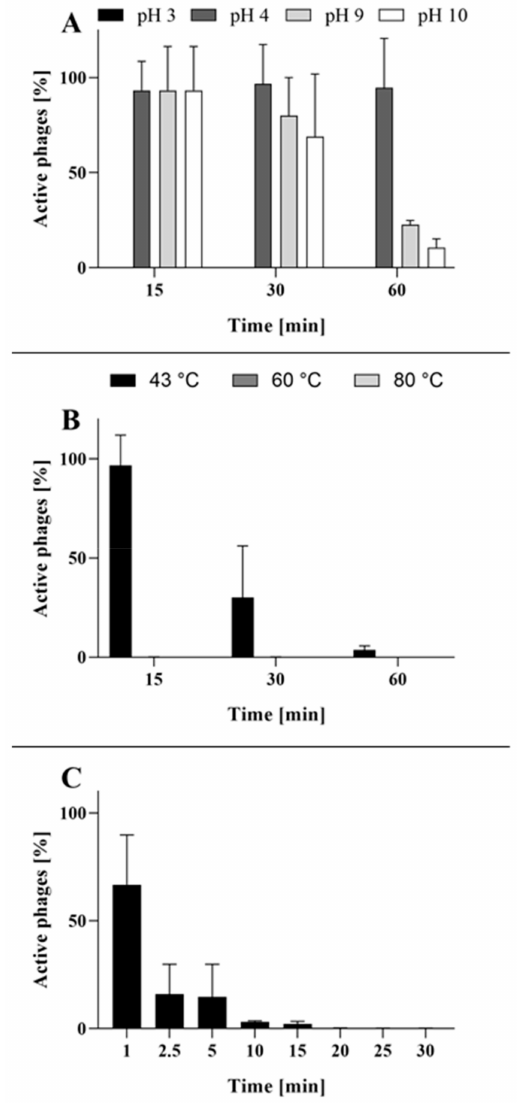
Figure 2. Phage BB8 stability under various conditions. ( A ) E ff ect of pH on the phage activity. The number of active phage particles at pH 3 was below the detection limit ( < 400 PFU / mL). ( B ) E ff ect of temperature on the phage activity. The number of active phage particles at 60 ◦ C and 80 ◦ C was below the detection limit ( < 400 PFU / mL). ( C ) E ff ect of UV radiation on the phage activity. The presented results are average values from three experiments, with SD represented by error